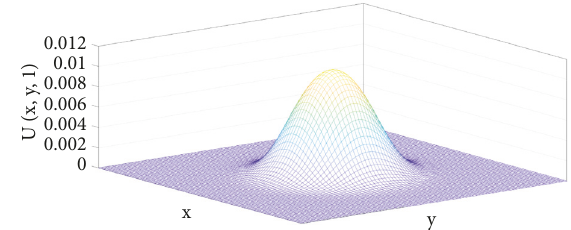
Figure 3: Numerical solution for two space dimension in an unbounded domain for 𝑡 = 𝑇 = 1 .